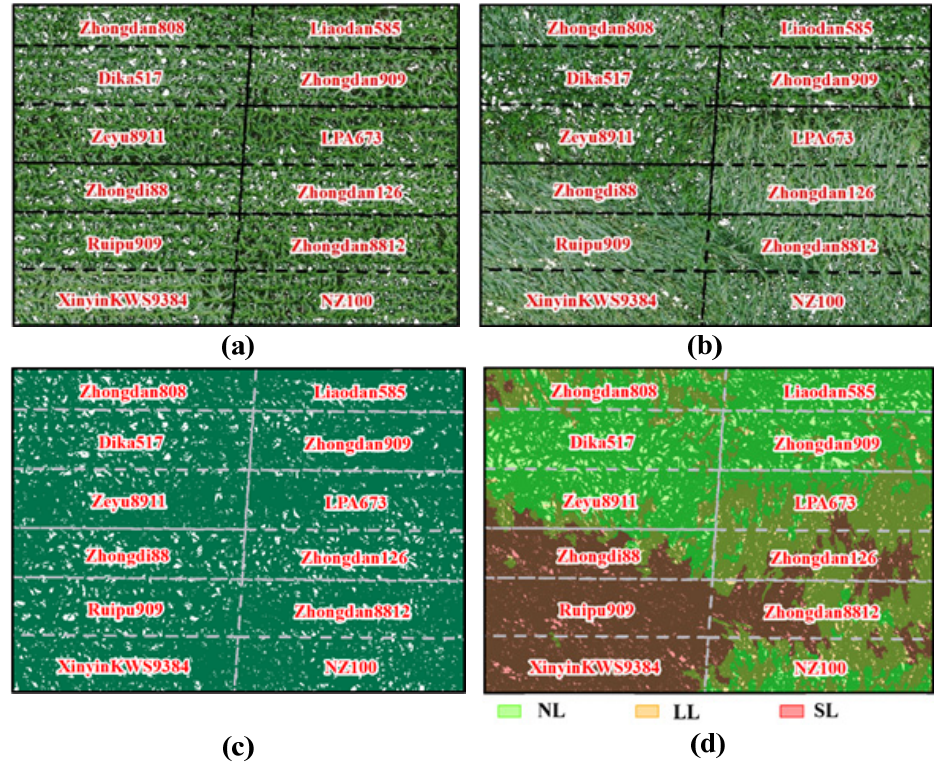
Figure 5. Results of vegetation-coverage extraction (because the image is too large, only the image near the variety is displayed). ( a ) Image before lodging and after removing the soil background. ( b ) Image after removing soil background. ( c ) Vegetation coverage before lodging. ( d ) Vegetation cov- erage after lodging. The colors on the map are the superposition of the later classification